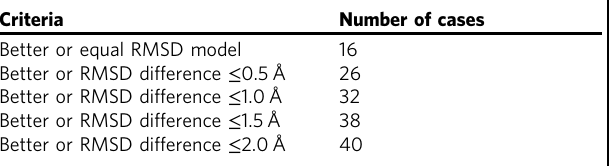
The data set was taken from Supplementary Table 1 in the RosettaES paper 28 . These proteins have their EM maps of a 3-5Å resolution and deposited structure models available in EMDB. The results of RosettaES and RosettaCM were taken from the columns of the best scoring resultsintheSupplementaryTable1oftheRosettaESpaper.Thenumberofcasesamongthe44 modeled fragments were counted where MAINMAST constructed a lower RMSD conformation to the native conformation than RosettaES or worse than RosettaES models but within a speci fi ed